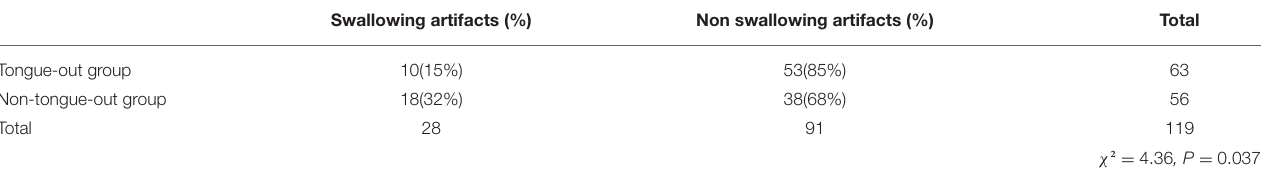
TABLE 4 | The incidence of swallowing artifact between the tongue-out group and the non-tongue-out group (The chi-square